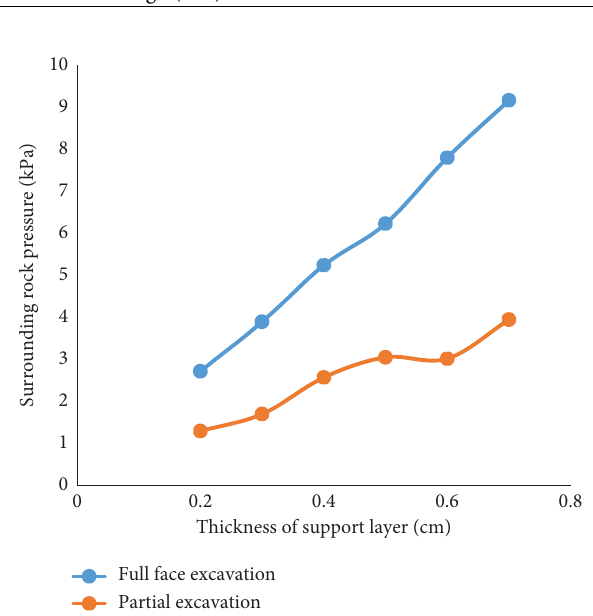
Figure 9: Comparison of surrounding rock pressure of diferent excavation